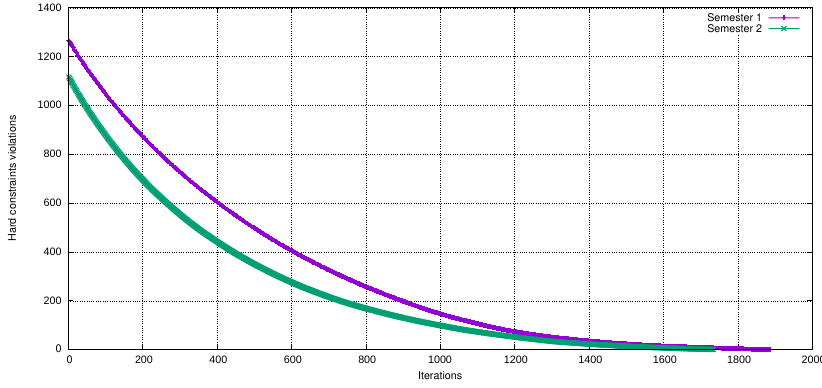
Figure 18. Solving the hard constraints in the TTP phase.